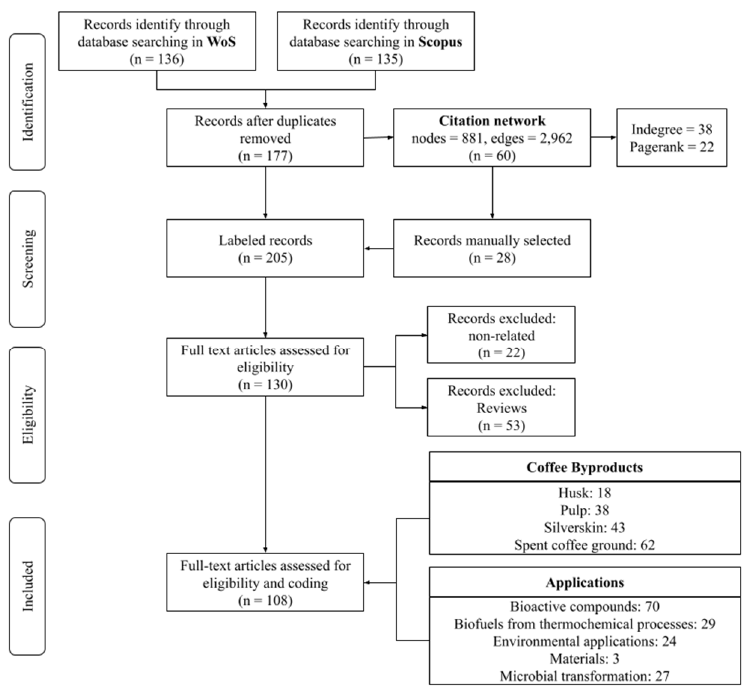
Figure 1. General flow diagram used to select papers based on the PRISMA guidelines.